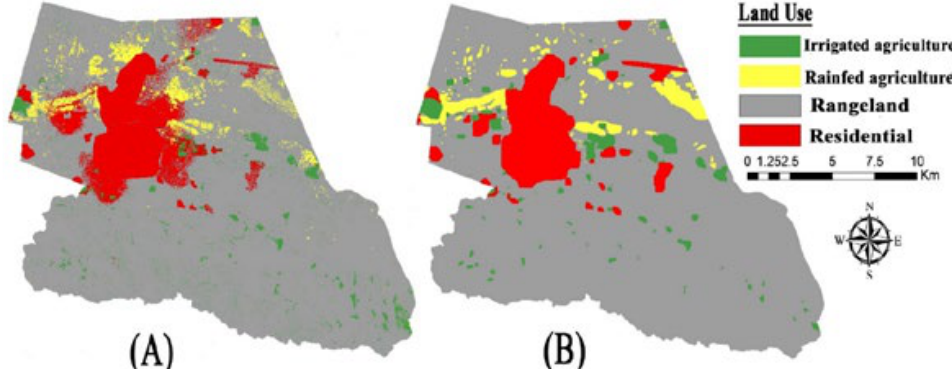
Fig. 9: Markovian LUCC simulation of Birjand plain in 2025 by MLP (A) and Fuzzy-AHP (B) transition potential and suitability mappers